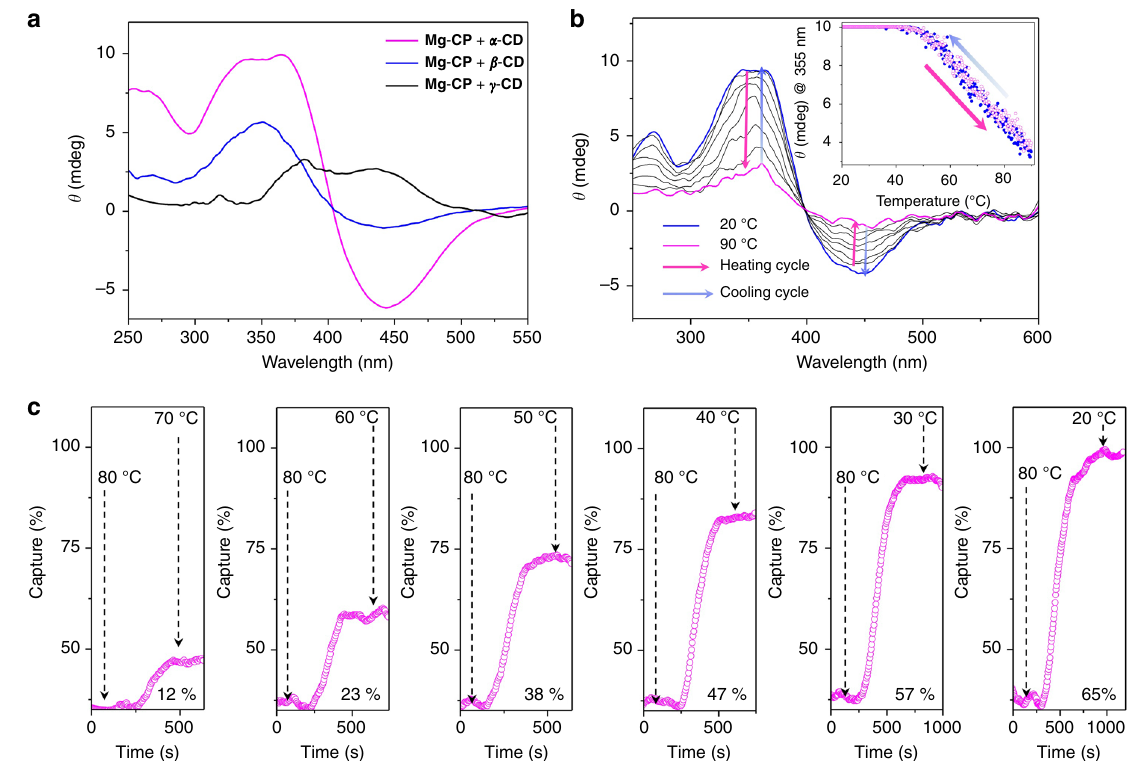
Fig. 5 Induced circular dichroism (ICD) capture – release studies of CD complexes of Mg-CP . a ICD spectra of Mg-CP in presence of α -, β - and γ -CDs . b Temperature-dependent ICD spectra of Mg-CP ⊃ α -CD . Inset shows the changes in the intensity of the ICD band at 355 nm on heating (magenta) and cooling (blue) a solution of Mg-CP ⊃ α -CD in water between 20 and 90 °C. c Stepwise temperature-controlled quantitative capture of α -CD by an aqueous solution of Mg-CP . Concentration of Mg-CP is 0.06 mg mL − 1 and that of α - , β - and γ -CD is 1 × 10 − 3